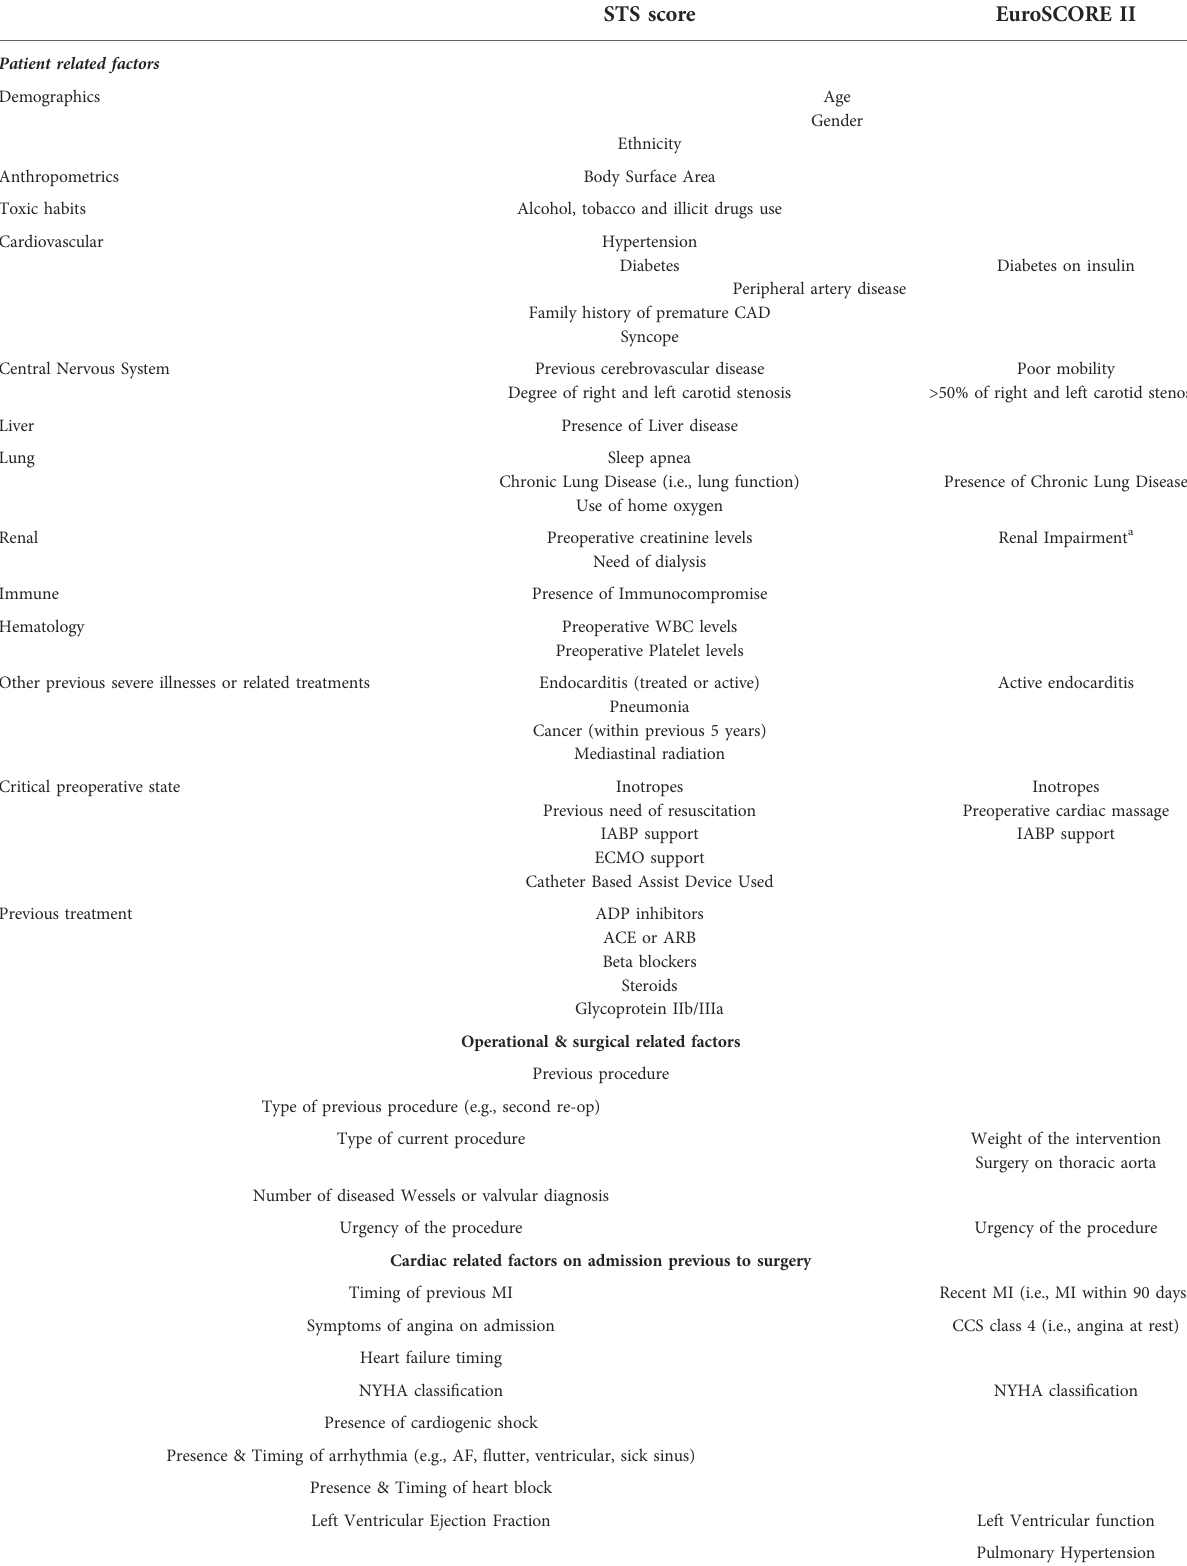
TABLE 2 Comparison between different variables included within main systems for evaluating perioperative risk in adult cardiac